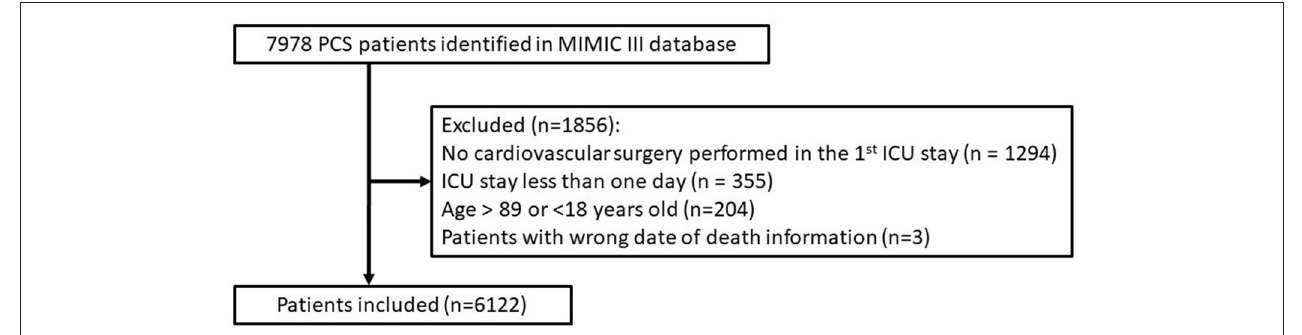
FIGURE 1 | Flowchart of study cohort